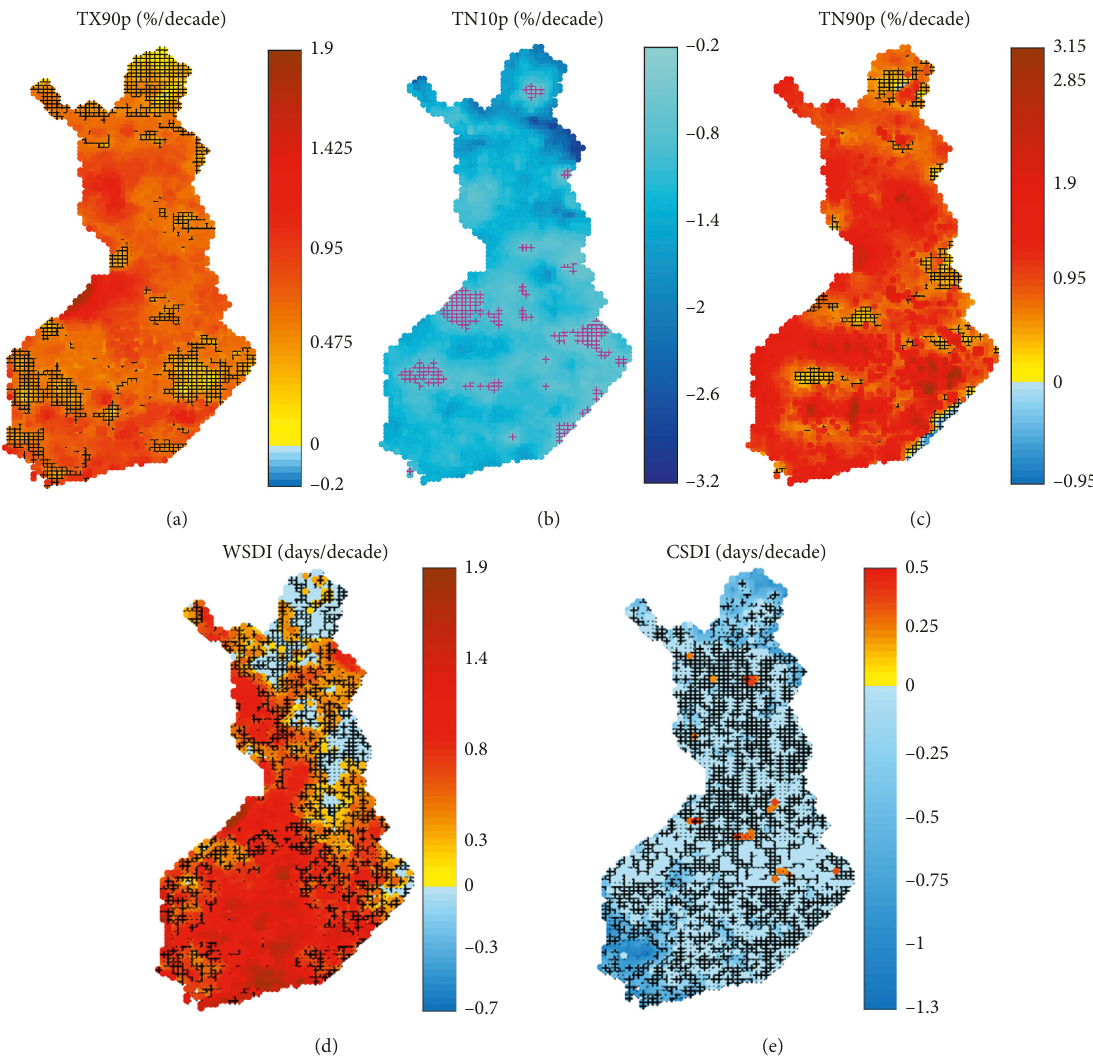
Figure 8: Spatial distribution maps of trends (/decade) in (a) TX90p, (b) TN10p, (c) TN90p, (d) WSDI, and (e) CSDI in Finland during 1961–2011. The stippling indicates areas where the trends are statistically insignificant ( p